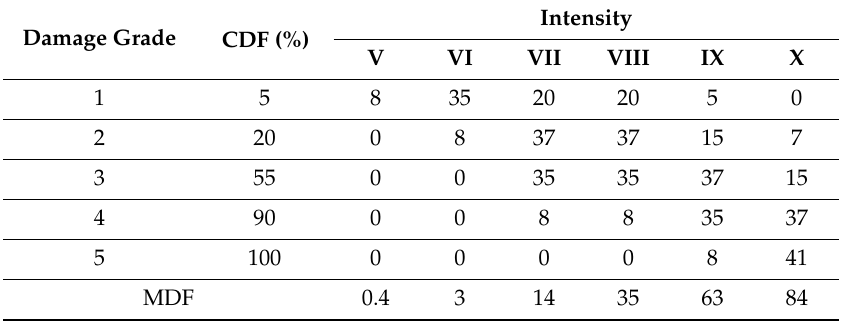
Table 1. Damage probability matrix (DPM) presented by Eleftheriadou and Karabinis [23] for Basel. Damage Grade CDF